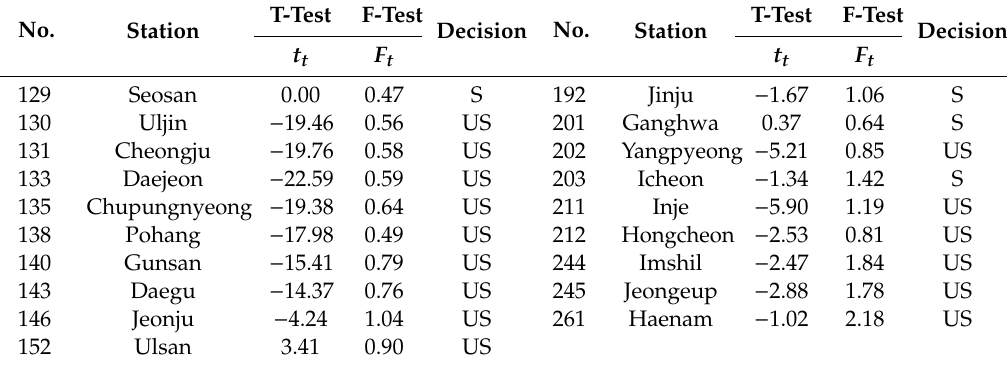
16 of 27 Table 4. Simple T-test and F-test analysis of annual precipitation data. No.